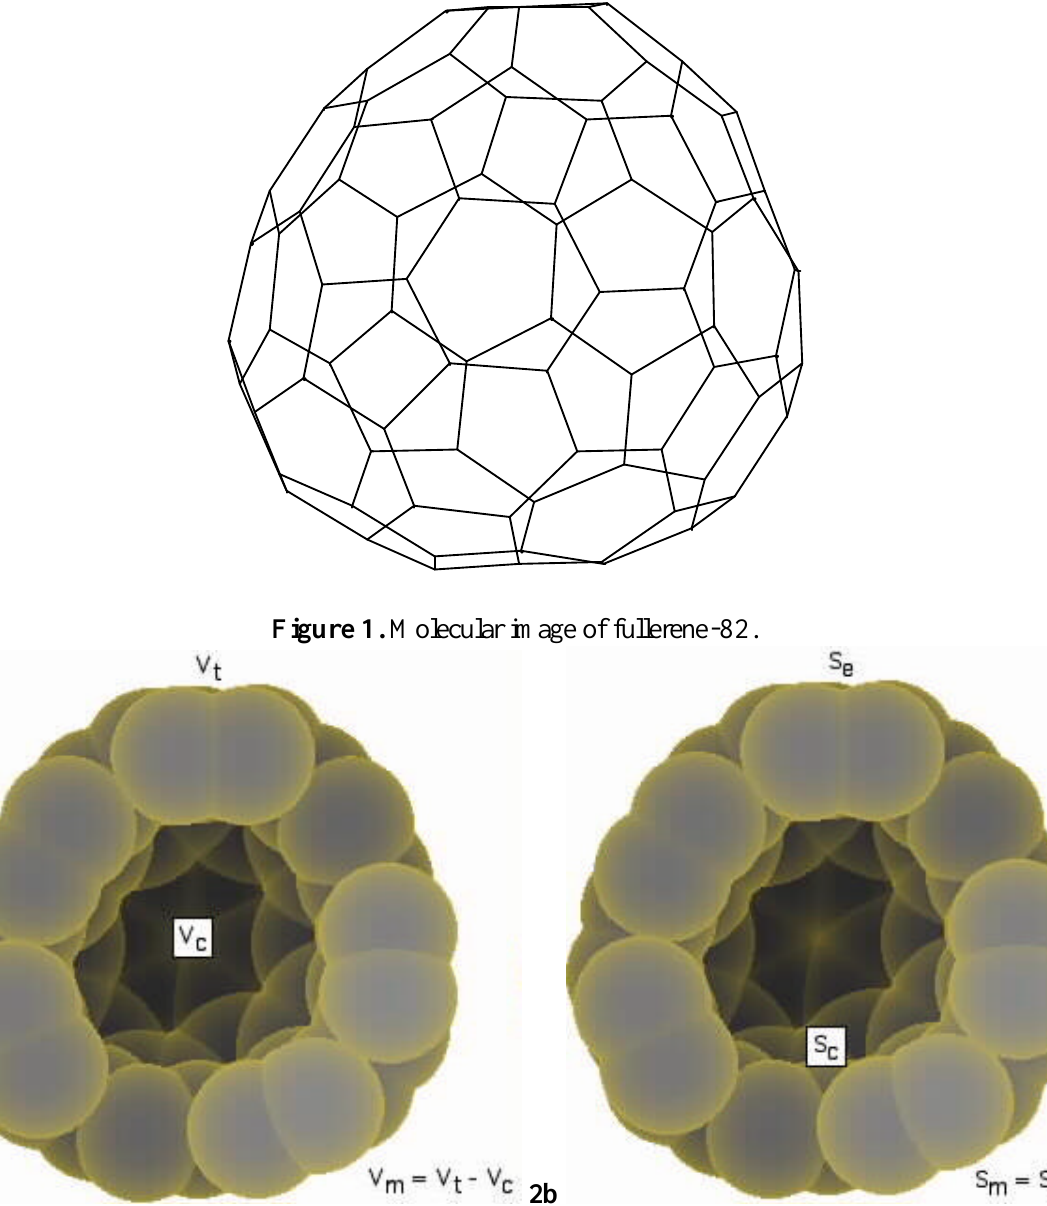
, cavity volume V , and total volume V m c